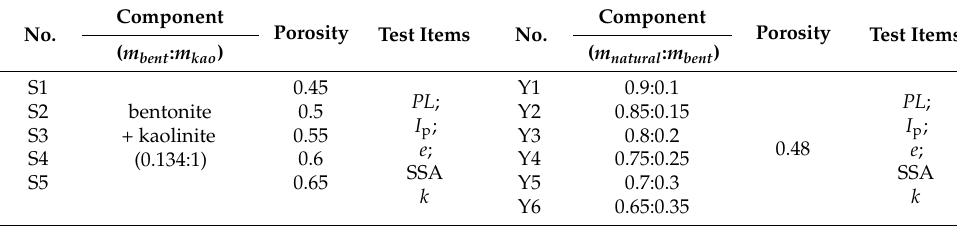
Table 2. The mixture table for the two types of soil samples.